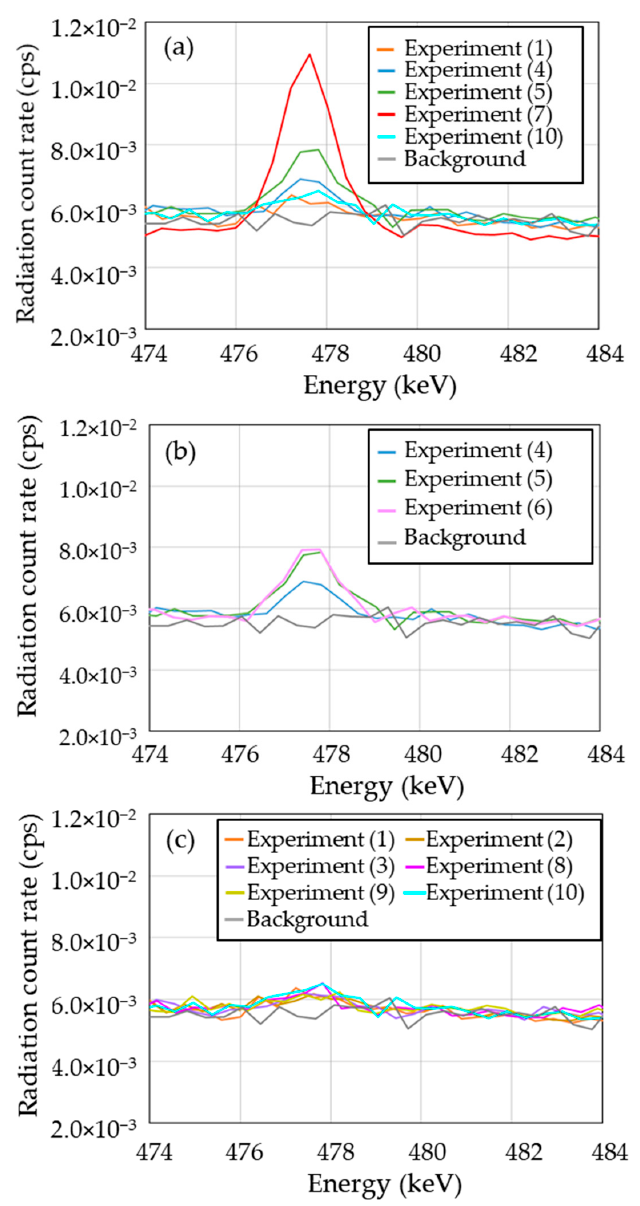
Figure 9. Energy spectra of all irradiated specimens and background in the range of 474–484 keV. ( a ): effect of physical dose, ( b ): effect of beam energy, ( c ): effect of specimen type.